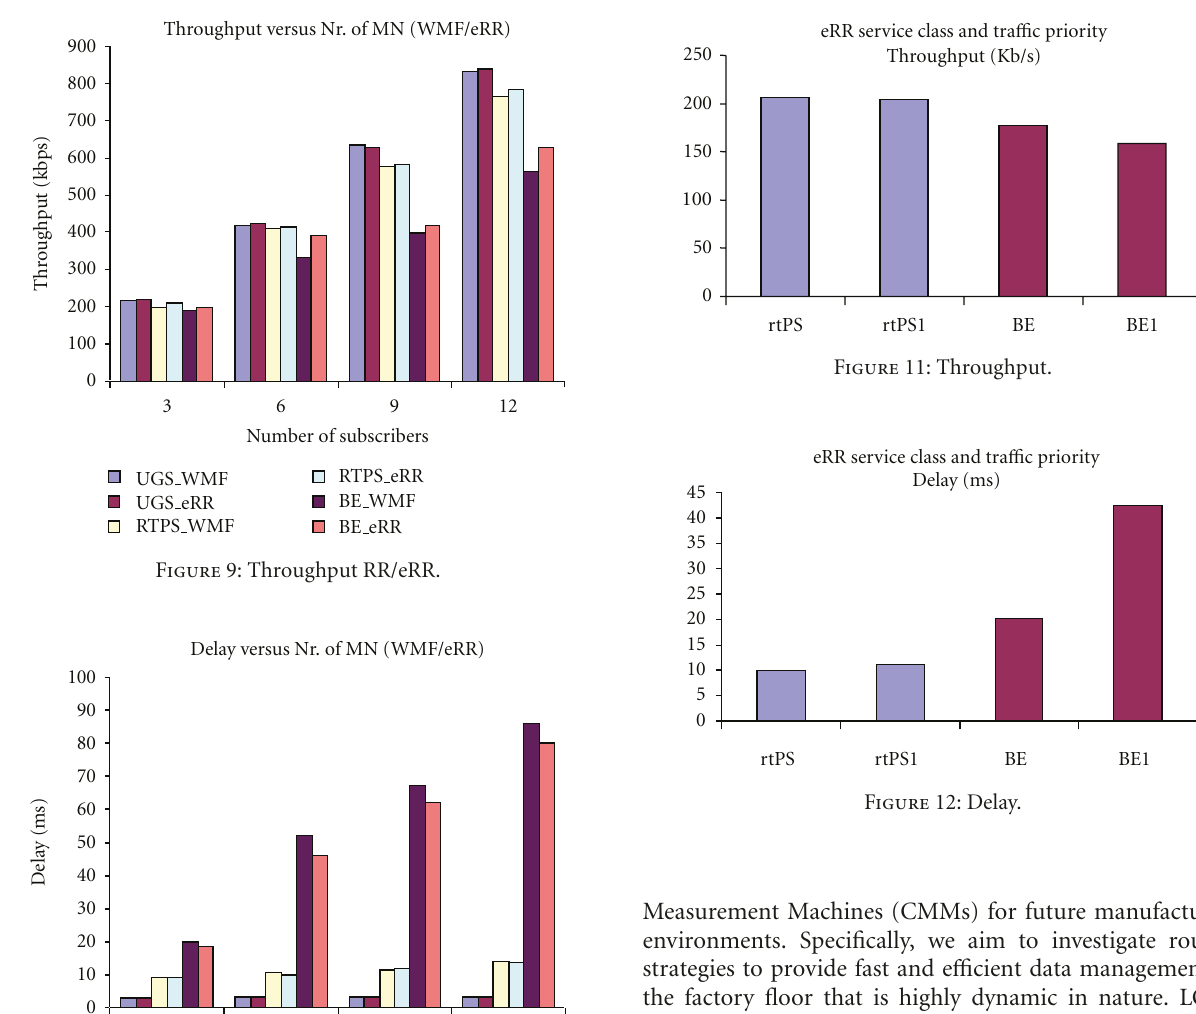
Figure 11: Throughput.